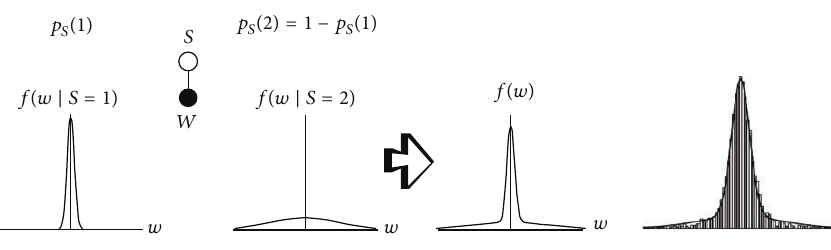
Figure 2: Zero-mean Gaussian mixture model (left image) and empirical histogram of wavelet in a subband together with the Gaussian mixture model (right image) [26].